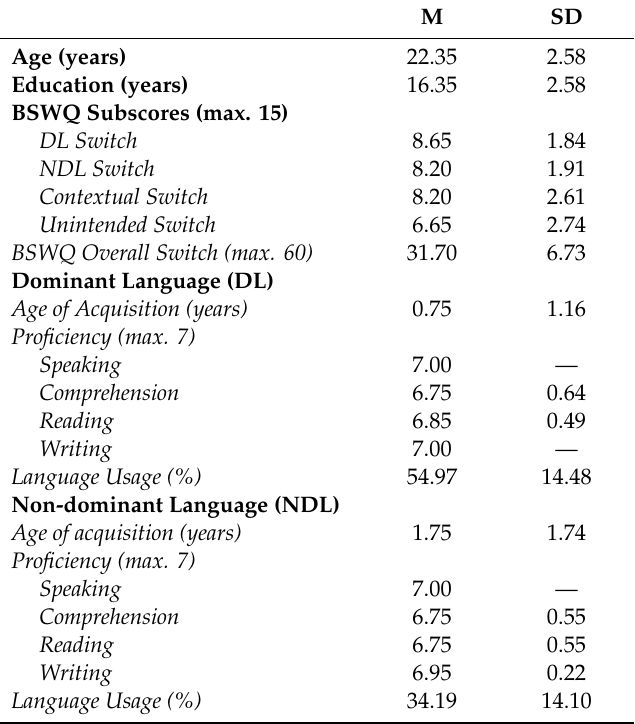
Table 1. Sociodemographic and linguistic measures for young Catalan-Spanish